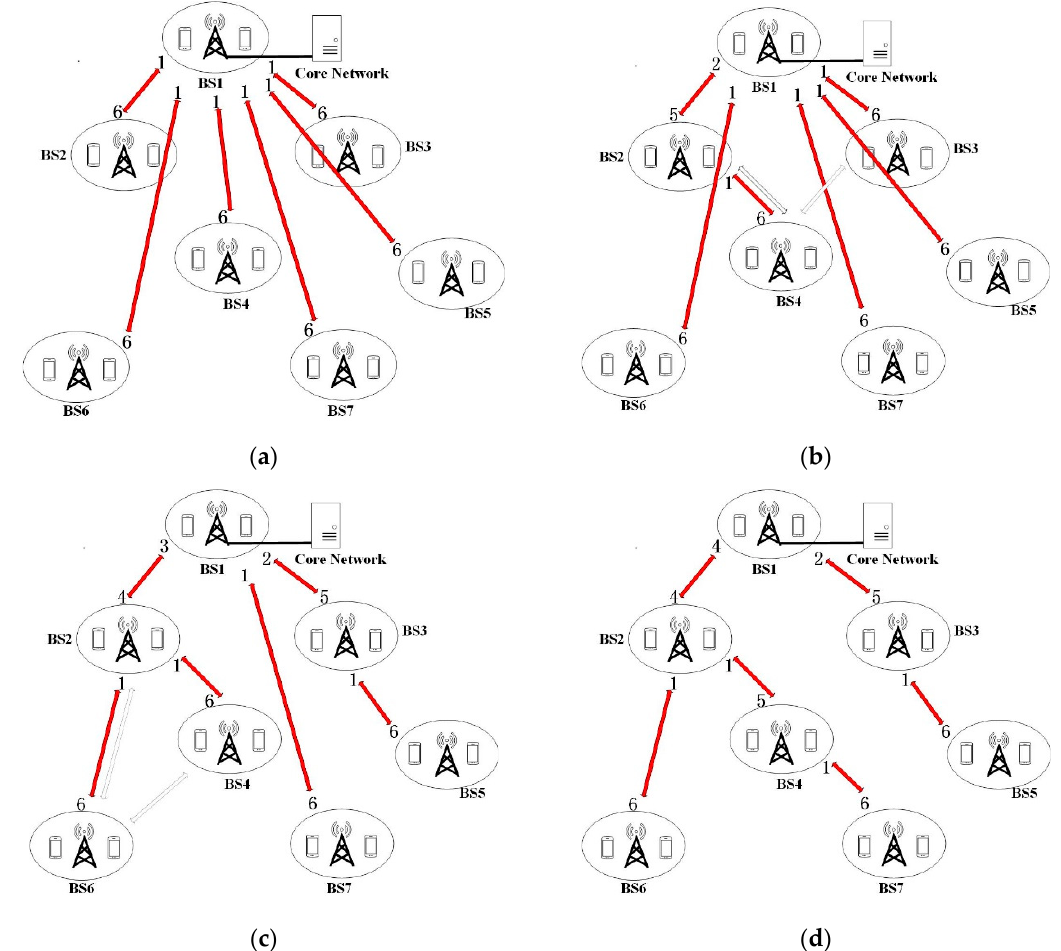
Figure 3. Example of PSR: ( a ) Initialization, ( b ) select parent node of BS 4 , ( c ) select parent node of BS 5 , (d) complete the entire topology.